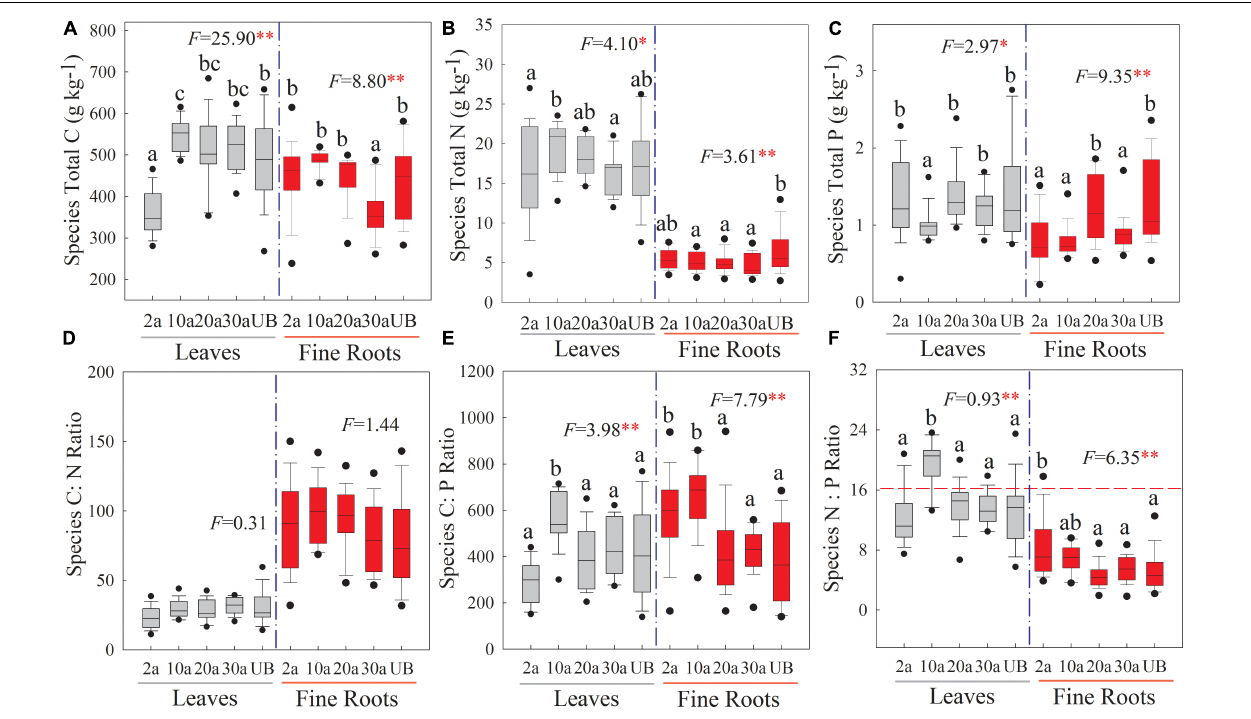
FIGURE 3 | Changes in the stoichiometry of leaf and fine root at the species level in different recovery periods. Boxplots stand for the range of C, N, and P stoichiometry during recovery periods. The dashed horizontal line stands for N:P ratio = 16 above which indicates the P limitation in subfigure (f). 2a, 10a, 20a, and 30a are at year 2, year 10, year 20, and year 30 after recovery, respectively. UB, unburned. Error bars are standard errors. Different lowercase letters indicate significant differences among different recovery periods. The number of the data involved in ANOVA in each recovery period was as follows: 2a: n = 39, 10a: n = 48, 20a: n = 36, 30a: n = 30, UB: n = 30 (** P < 0.01; * P < 0.05). (A–C) The stoichiometry concentration. (D–F) The stoichiometry